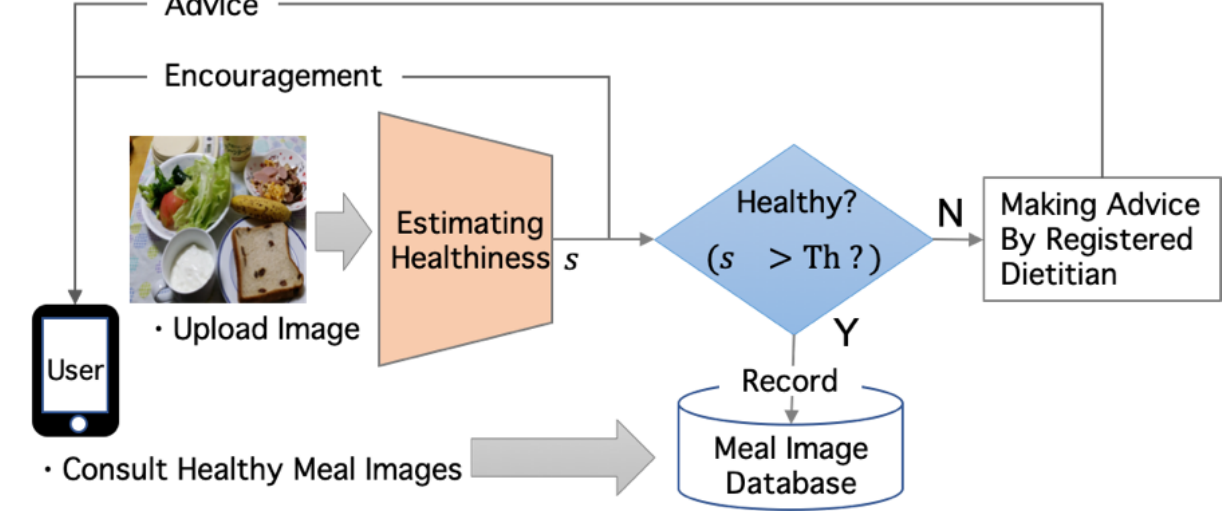
Figure 1. Workflow of the screening system and the image database of healthy meals for those who need the advice of a registered dietitian to improve their